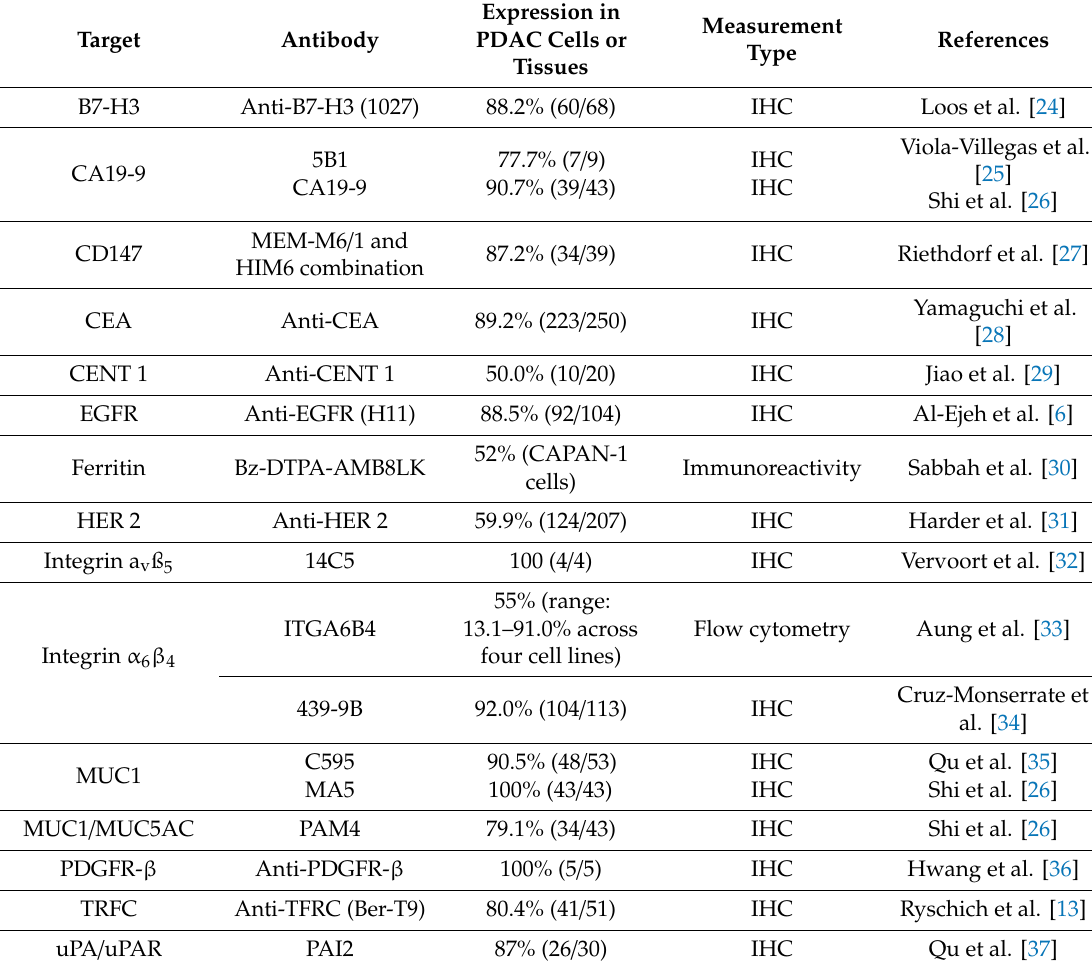
Table 2. Expression of RIT targets in